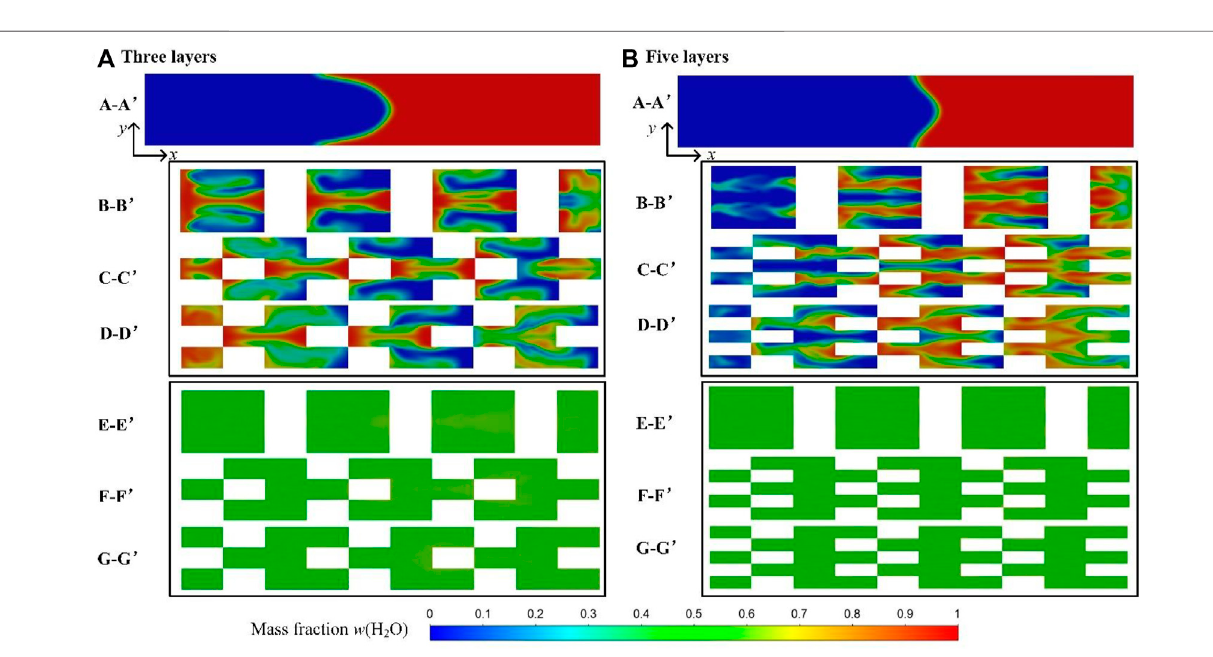
Frontiers in Chemical Engineering |